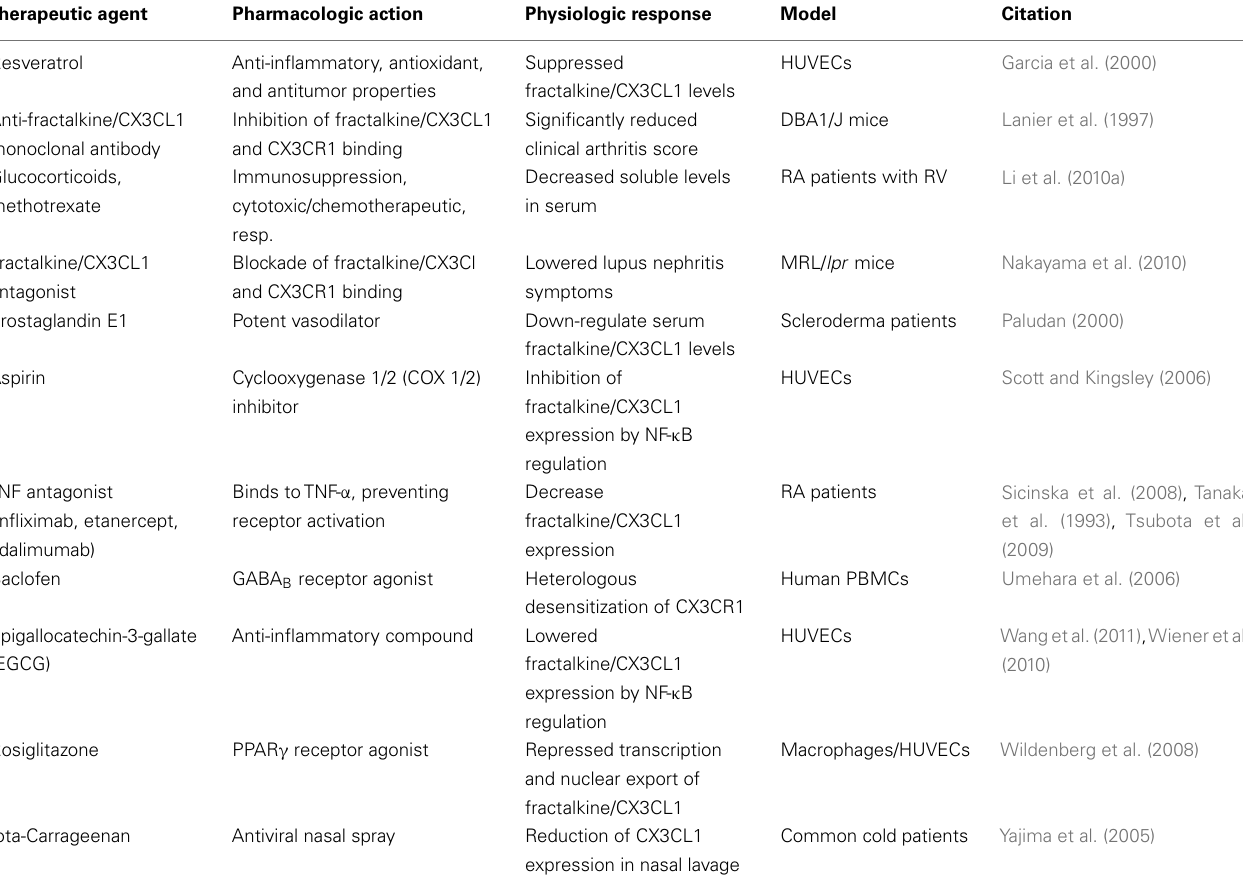
Table 2 | Potential therapeutic strategies to regulate fractalkine/CX3CL1 in rheumatic diseases. Therapeutic